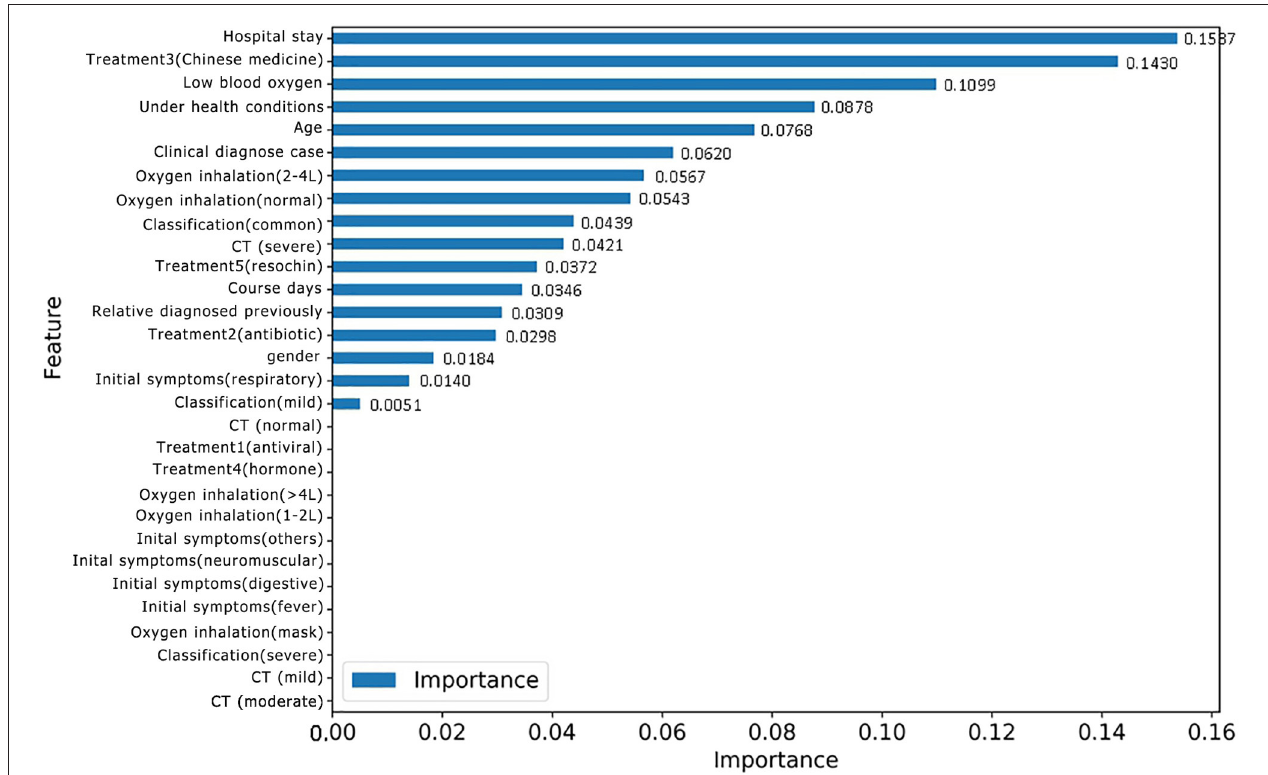
FIGURE 6 | Feature importance based on the new RF model for classifying patients with or without positive RT-PCR after leaving